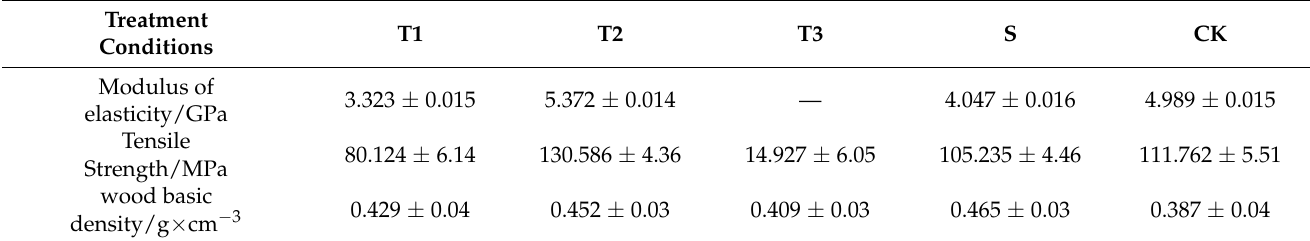
Table 3. Tensile properties of the poplar flakes treated and wood basic density by different sustained- release drip conditions, The values after the +/ − sign represent the standard deviation; T1, T2, T3 represent the 110,100 mmol/L TEOS modification treatment group; S represents the SiO 2 colloidal injection group; CK represents the unmodified treatment